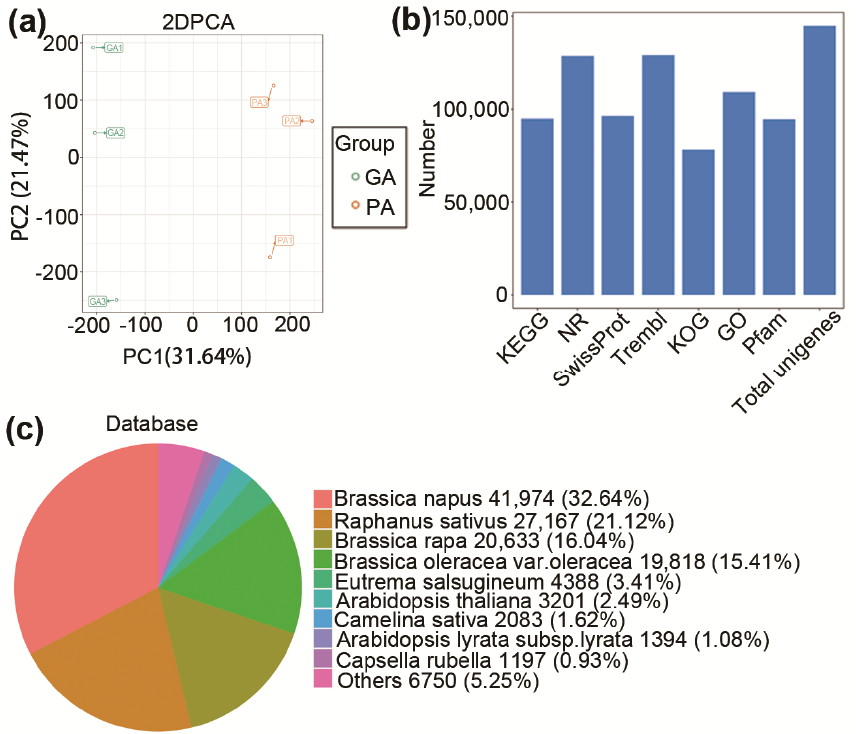
Figure 3. Functional annotation of transcriptome sequencing. ( a ) PCA analysis of the variance-stabilized estimated raw counts of differentially expressed genes (DEGs). ( b ) Functional annotation numbers of unigenes in the KEGG, NR, Swiss-Prot, Trembl, KOG, GO, and Pfam databases. ( c ) Annotated species distribution in the NR database.